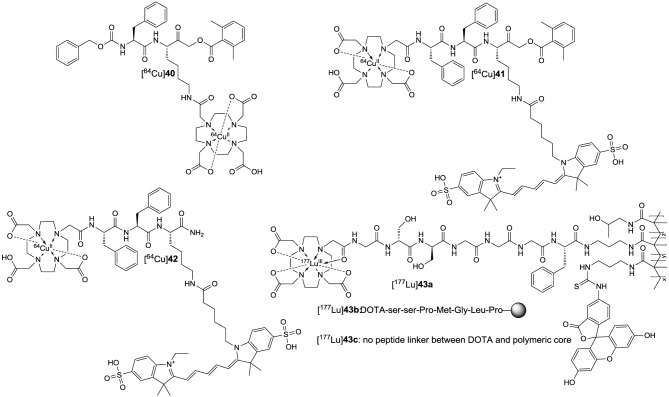
Radiometal-based cysteine-cathepsin targeting radiotracers.